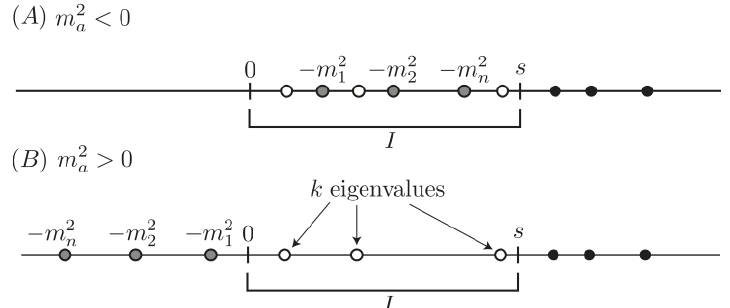
Figure 12 . The determinantal random point process for x i i = 1 ; : : : ; N + n with designated points at (cid:0) m 2 ( a = 1 ; : : : ; n ). (A) For m 2 a